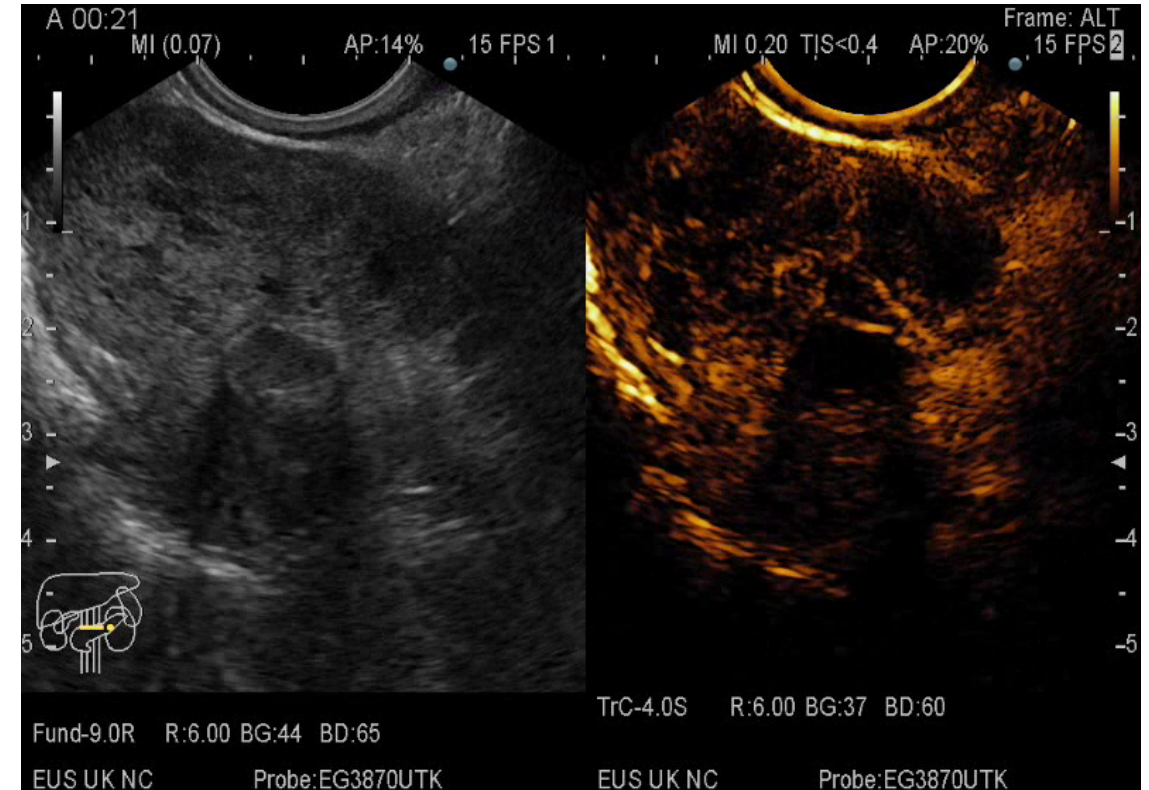
Figure 6. CE-EUS image of a pNEC (pancreatic neuroendocrine carcinoma) with aspect in the arterial phase and wash-out in the venous phase. Table 6. Contrast enhancement patterns of the main pancreatic lesions. Values are number of patients